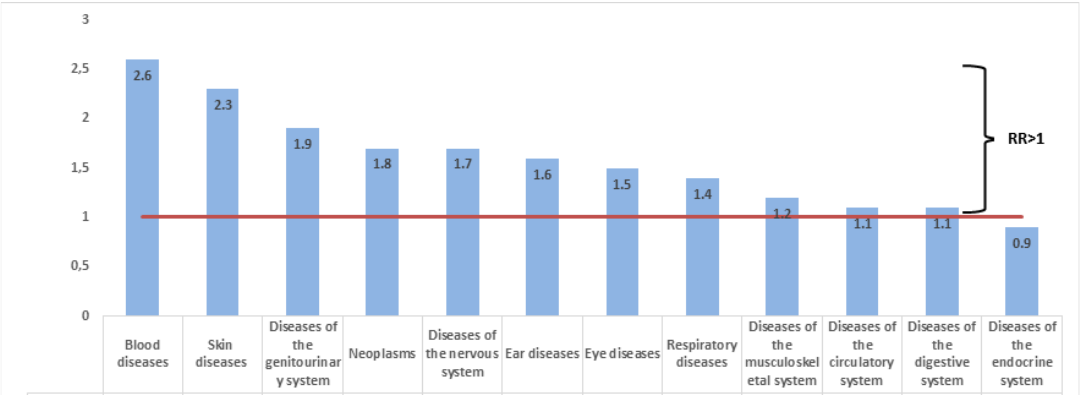
Figure 3. Relative risks of somatic diseases in the population from Bidaykol according to the ICD-10 classes.